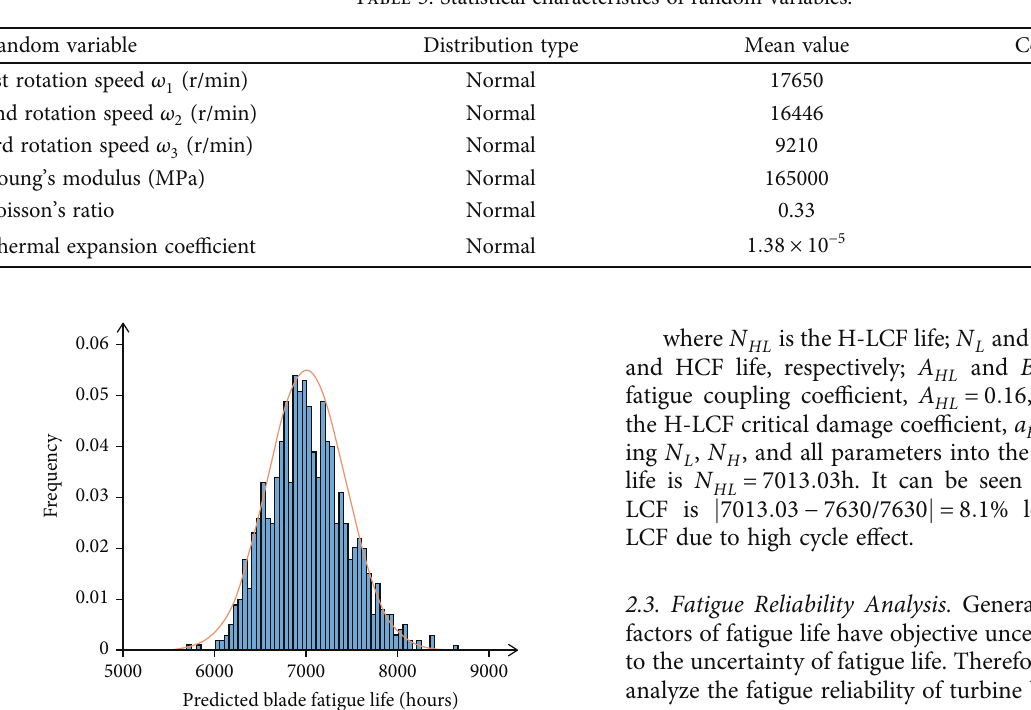
Table 5: Statistical characteristics of random variables.